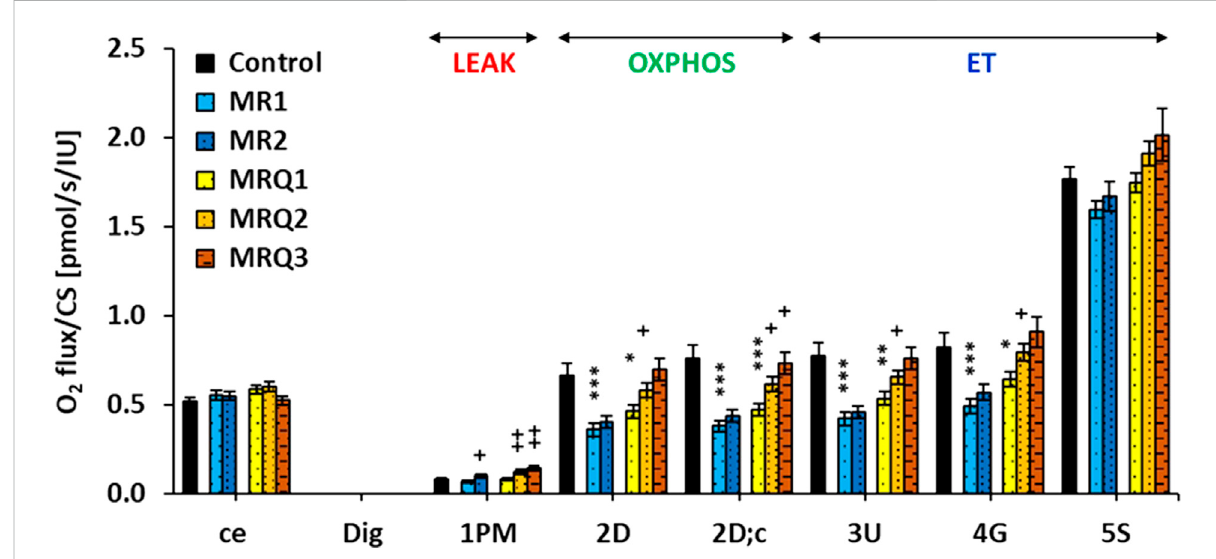
FIGURE 3 Platelet mitochondrial respiration in control subjects and patients with post C-19. The respiration was measured in freshly isolated platelets following substrate-uncoupler-inhibitor titration (SUIT) reference protocol 1 (Doerrier et al., 2018) and valuated as O 2 fl ux per mitochondrial marker citrate synthase activity, J O 2 /CS (pmol/s/IU). A) The graph show mean ± sem of the respiratory capacities after titration step indicated on the x -axis: ce — intact cells; Dig — digitonin; 1p.m. — pyruvate plus malate; 2D — ADP — adenosine diphosphate; 2D; c — cytochrome c; 3U — uncoupler